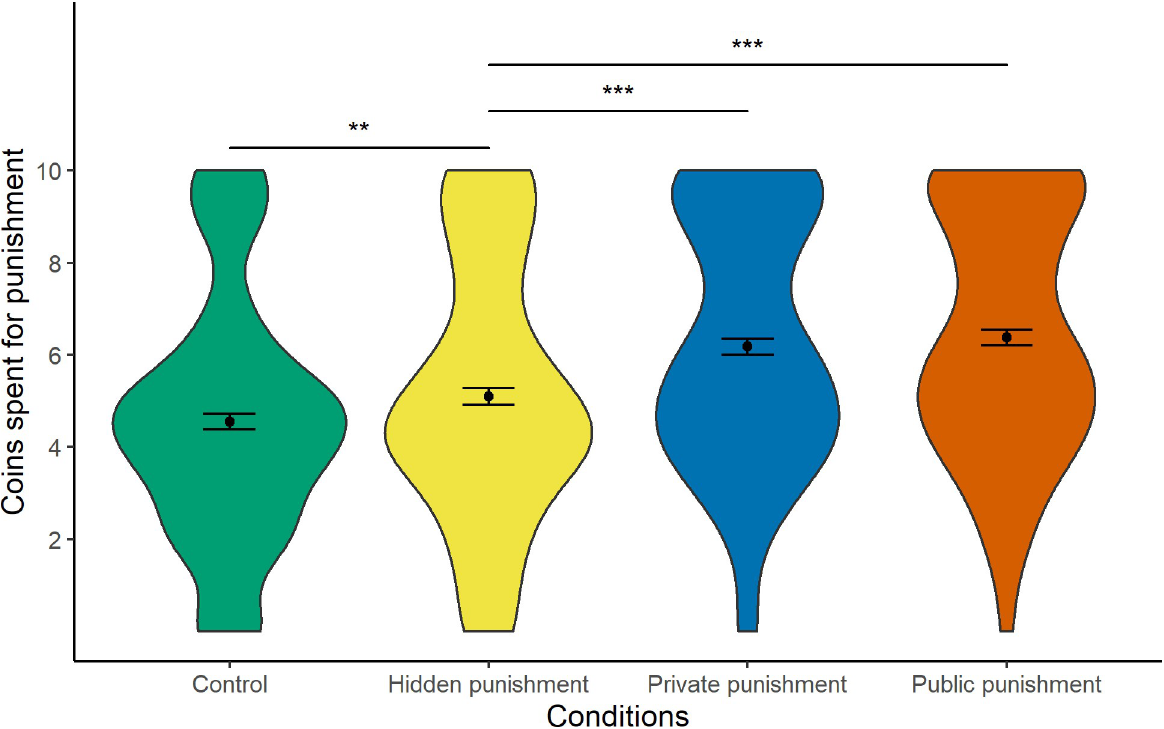
Fig 3. Coins spent for punishment in the four conditions. Differences between the control condition and the hidden condition can be interpreted as a proxy for children’s willingness to sacrifice own resources for the sake of retribution. Differences between the hidden condition and the private condition can be interpreted as a proxy for children’s willingness to sacrifice own resources for the sake of special prevention. Differences between the hidden condition and the public condition can be interpreted as a proxy for children’s willingness to sacrifice own resources for the sake of general prevention. Error bars represent one standard error of the